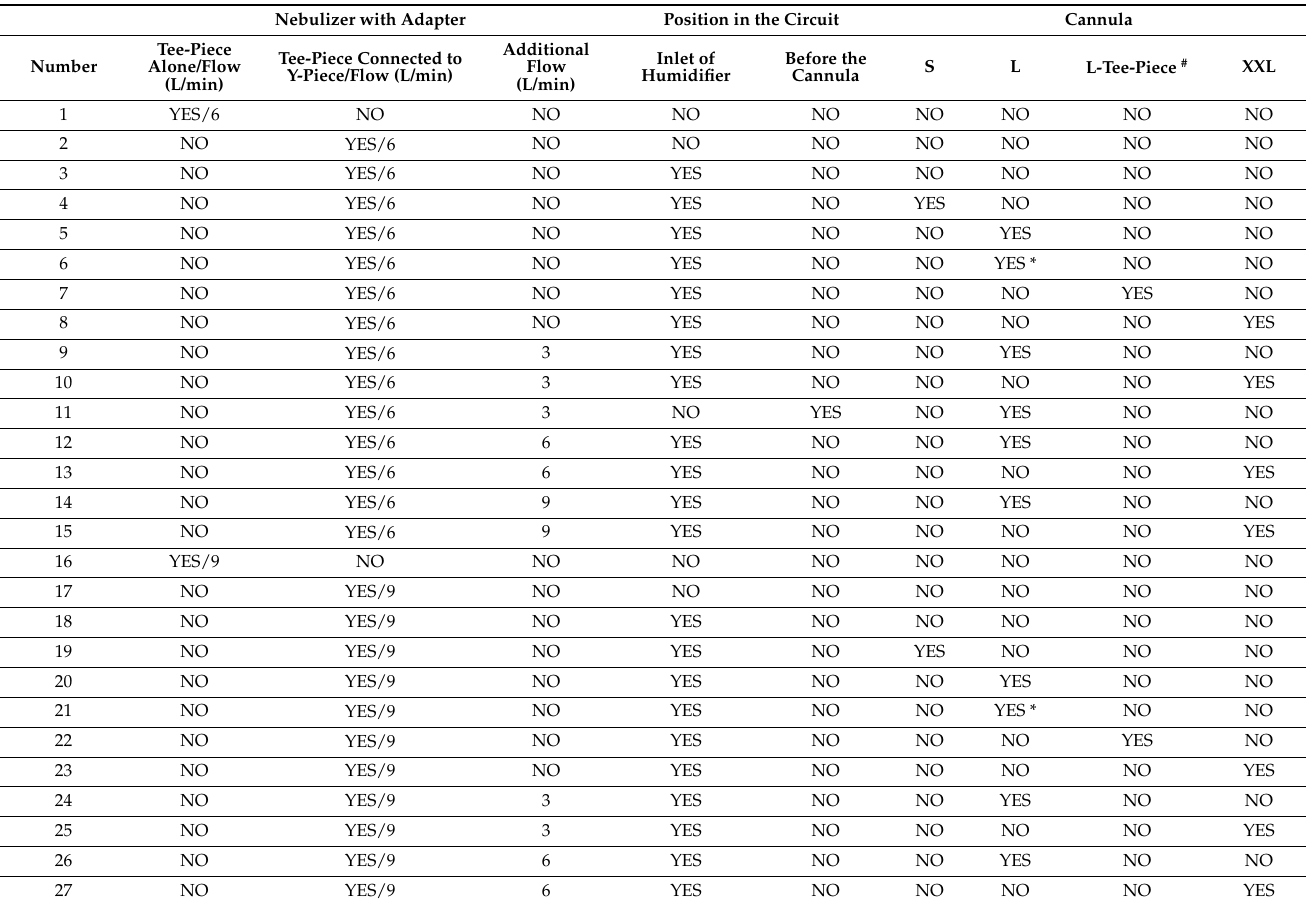
Table 3. Configurations of the tested scenarios.